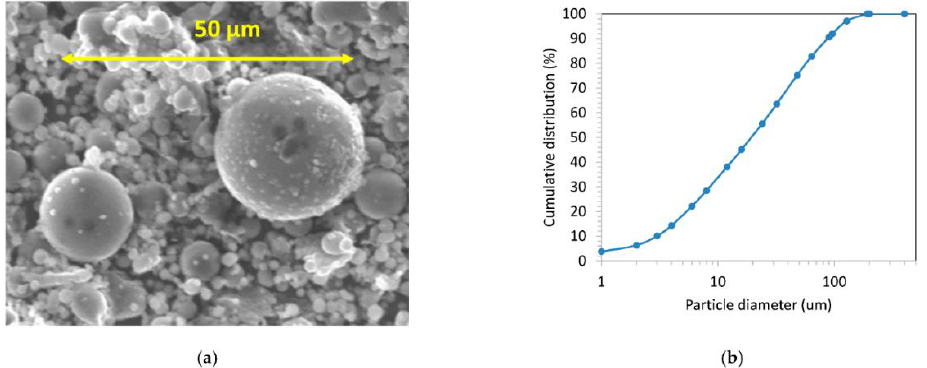
Figure 6. Scanning electron microscopy image ( a ) and particle size distribution ( b ) of the coal fly ash [22].